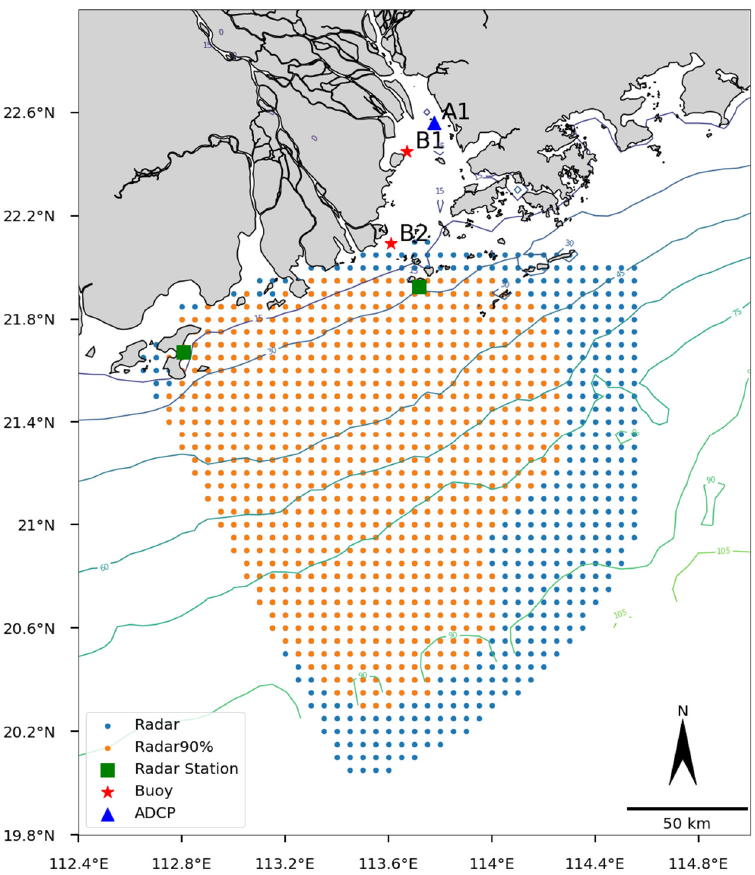
Figure 1. Map of the HF radar data domain. Blue spots indicate the original data points and orange spots indicate the data points with a data acquisition rate greater than 90%. The ADCP mooring station is marked by A1, and the two buoys are marked by B1 and B2. The two HF radar stations are marked by green squares.